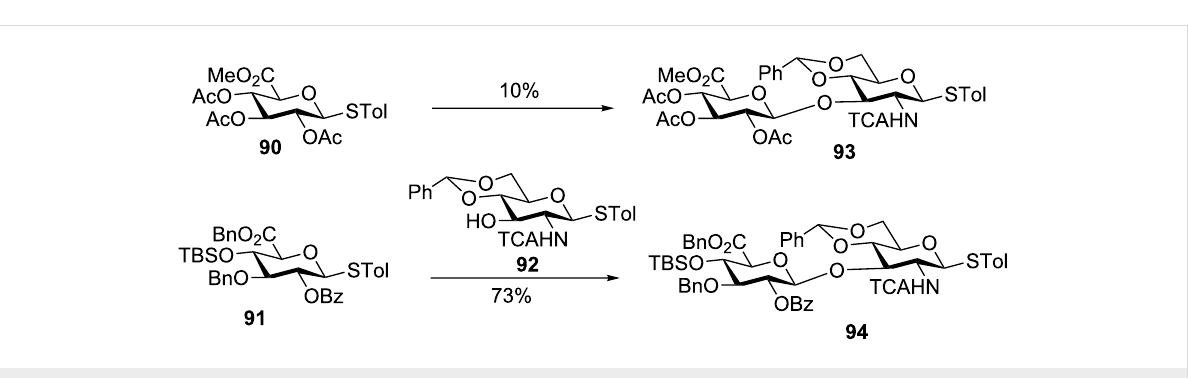
Scheme 16: The more electron-rich glycosyl donor 91 gave a higher glycosylation yield than the glycosyl donor 90 bearing more electron-with- drawing acyl protective